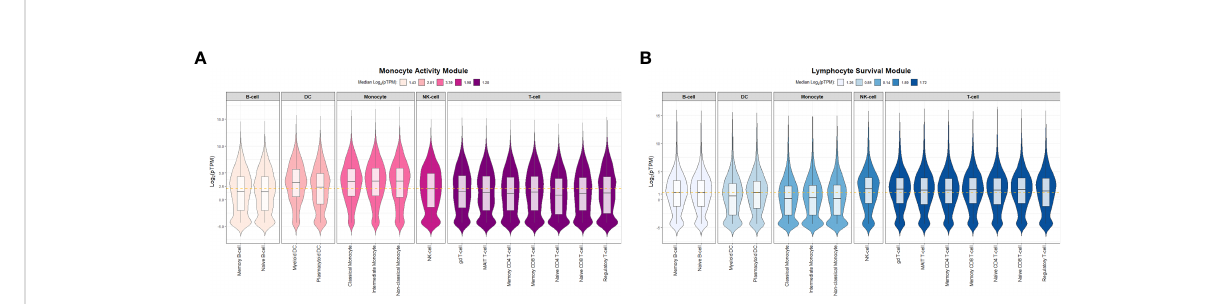
FIGURE 3 Absolute immune signal deconvolution of peripheral blood mononuclear cells based on the Human Protein Atlas. Violin plots demonstrate relative expression (log 2 -pTPM) of cell speci fi c genes. (A) The Monocyte Activity Module (MAM, magenta) was characterized by high relative expression of monocyte and dendritic cell genes and low relative expression of lymphocyte genes. (B) The Lymphocyte Survival Module (LSM, blue) was characterized by high relative expression of lymphocyte genes and low relative expression of monocyte and dendritic cell genes. For (A, B) median log 2 -pTPM values per cell type (B-cells, Dendritic cells [DC], Monocytes, Natural Killer [NK] cells, and T-cells) are shown in the fi gure legends. Signi fi cant differences in relative expression of cell speci fi c genes were identi fi ed between speci fi c cell types within MAM and LSM (Kruskal-Wallis test p-value < 0.05). Post hoc analysis with Benjamini-Hochberg (BH) adjustment for multiple comparisons was performed with Dunn ’ s test and BH.adj p-value <0.1 was considered signi fi cant. In MAM, all post hoc comparisons assessing differences in relative expression of cell type speci fi c genes were found to be signi fi cant with the exception of B-cell and T-cell genes which were comparable (BH.adj p-value =0.33). Similarly, in LSM all post hoc comparisons were signi fi cant except for NK-cell versus T-cells (BH.adj p-value =0.37). pTPM = normalized to transcripts per million protein coding genes. The gold dashed horizontal line represents the median log 2 -pTPM values among all genes in each module.